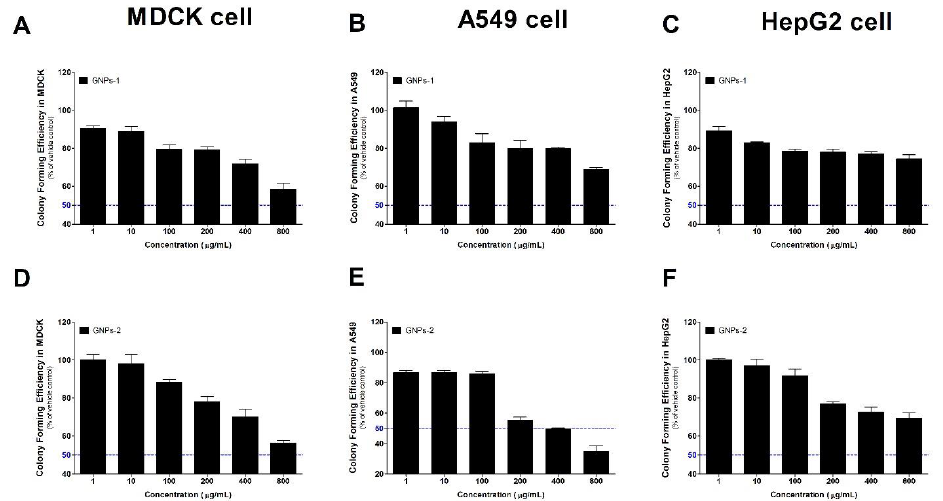
Figure 2. The colony-forming efficacy (CFE) assay results of graphene nanomaterials to MDCK, A549, and HepG2 cells. Results of GNPs-1 in ( A ) MDCK, ( B ) A549 and ( C ) HepG2 cells. Results of GNPs-2 in ( D ) MDCK, ( E ) A549, ( F ) HepG2 cells. Data are expressed as mean ± SEM ( n = 3). Blue line; 50 = The half